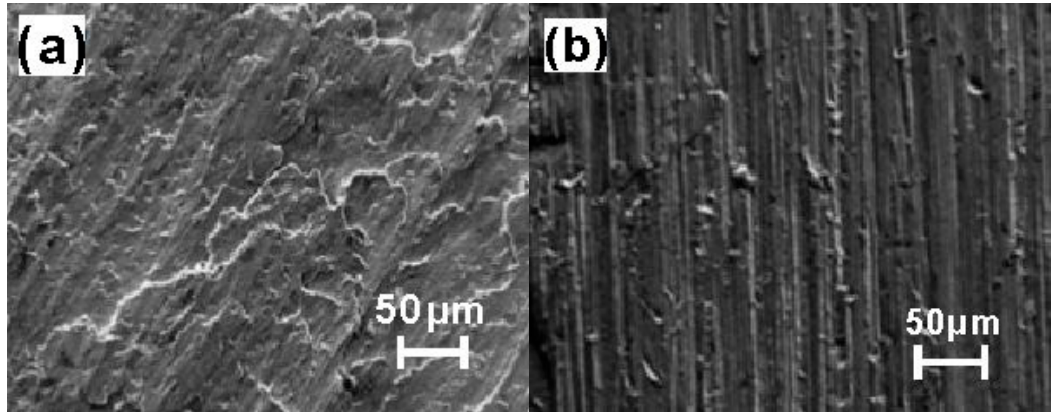
Figure 11. Worn surface morphologies of ( a ) the Cu substrate and ( b ) the Ni–Co duplex coating.